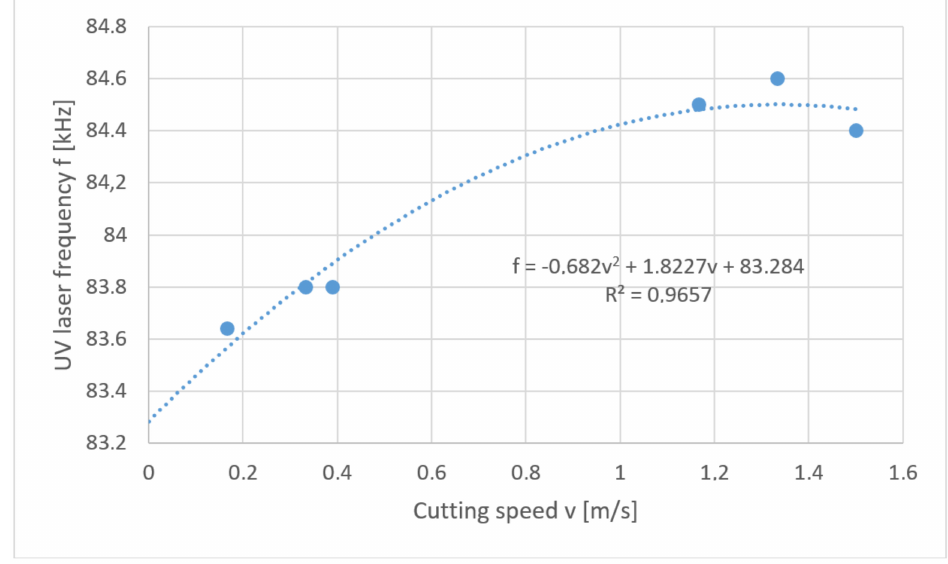
Figure 15. Reverse task solution for cutting foil with thickness t = 80 µ